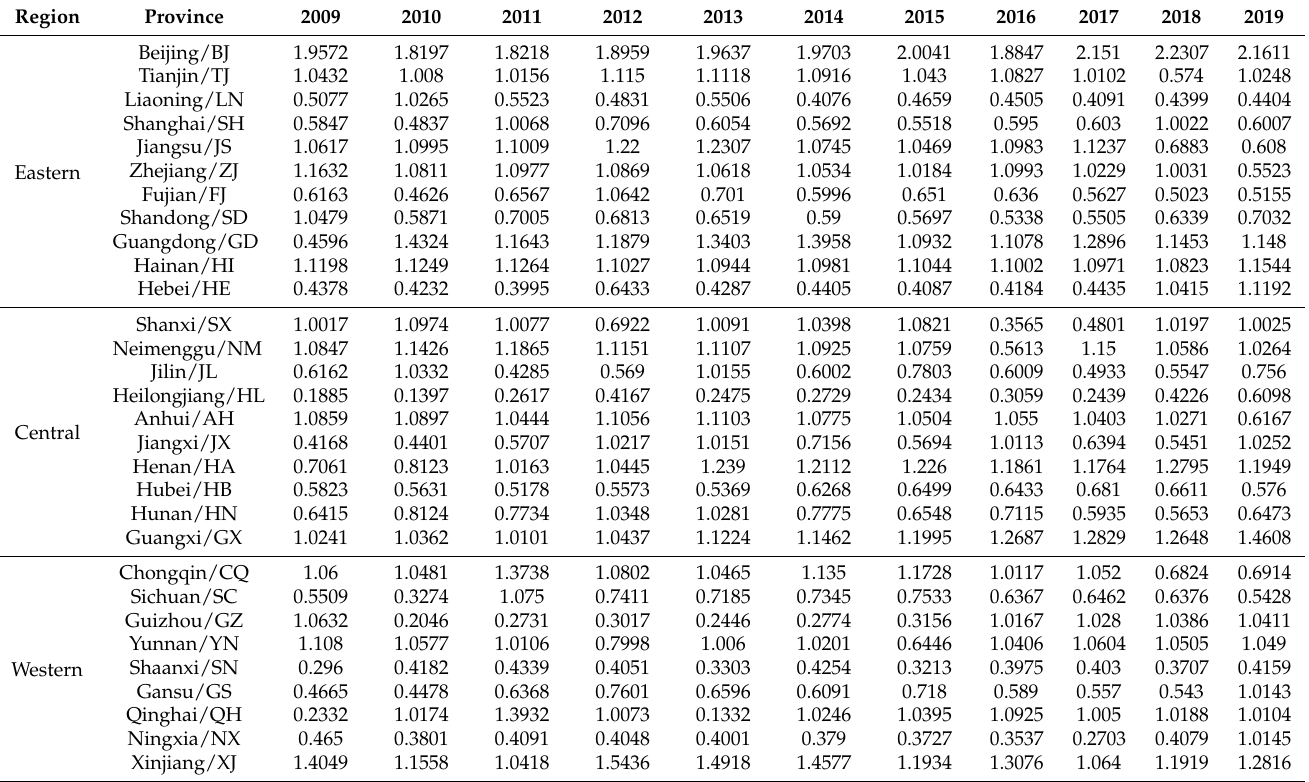
Table A1. Green innovation efficiency in China from 2009 to